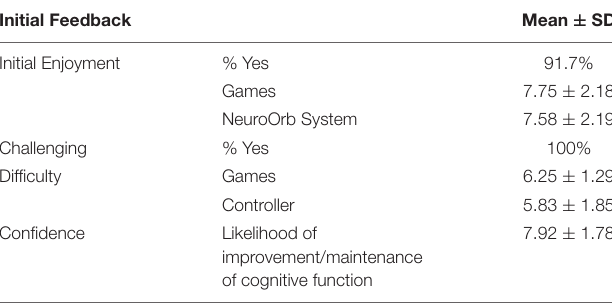
TABLE 3 | Session 1 – Initial feedback on the NeuroOrb